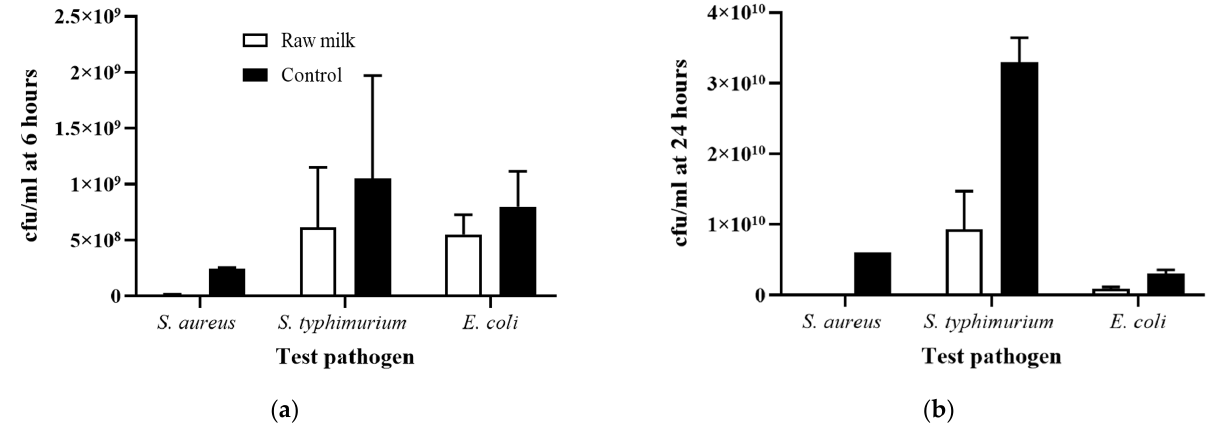
Figure 2. Bacterial growth of inoculants in raw DHM after 6 ( a ) and 24 h ( b ) incubation. Inoculants included S. aureus, S. typhimurium , and E. coli and were inoculated at 10 7 cfu/mL. Control is inoculant growth in LB broth. Values are the means ± SD of 2 biological replicates.